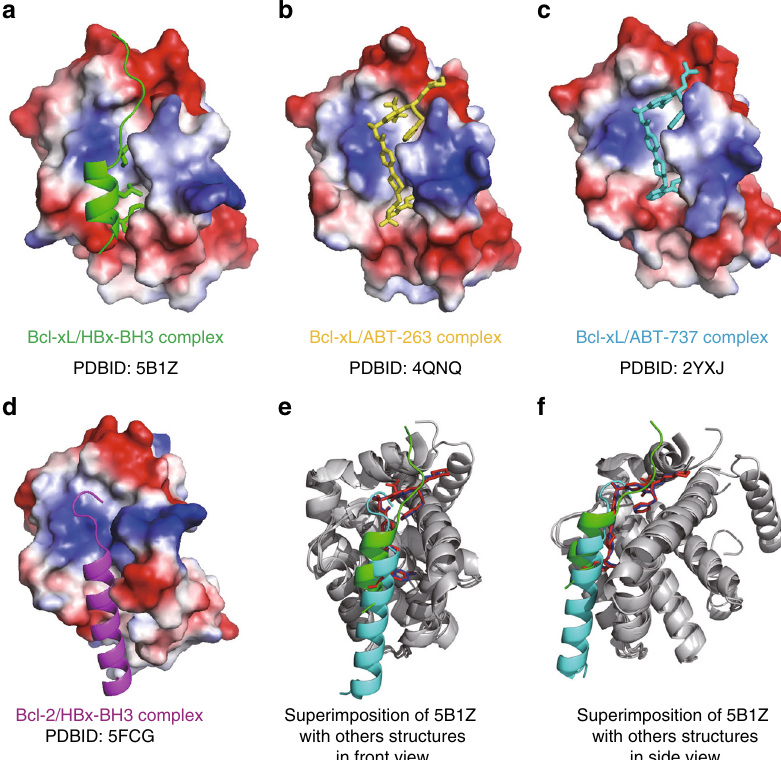
Fig. 5 Comparison of Bcl-xL/HBx-aa113 – 135, Bcl-xL/ABT-263, Bcl-xL/ABT-737, and Bcl-2/HBx-aa110 – 135 structures. a Cartoon structure of Bcl-xL in complex with HBx-aa113 – 135 (PDB ID 5B1Z). b Cartoon structure of Bcl-xL in complex with ABT-263 (PDB ID 4QNQ). c Cartoon structure of Bcl-2 in complex with ABT-737 (PDB ID 2YXJ 23 ). d Cartoon structure of Bcl-2 in complex with HBx-aa110 – 135 (PDB ID 5FCG 8 ). The structures of Bcl-xL and Bcl-2